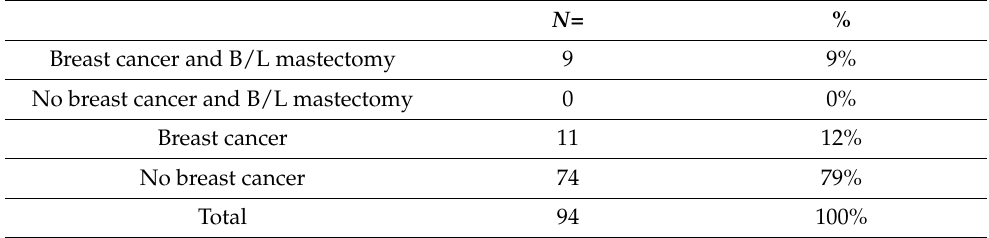
Table 4. History of breast cancer and mastectomy in women carrying PVs in Lynch syndrome